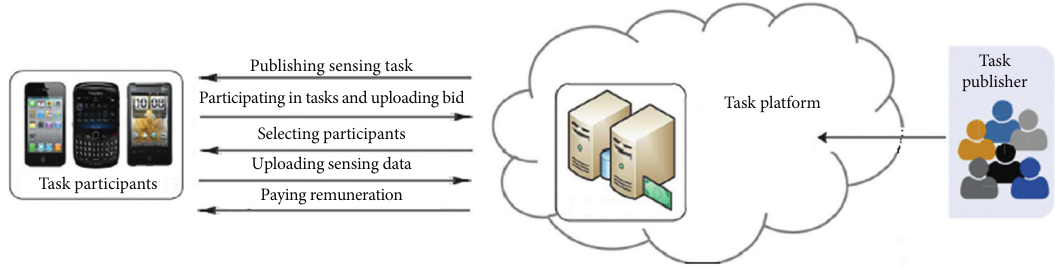
Figure 1: Mobile crowdsensing network